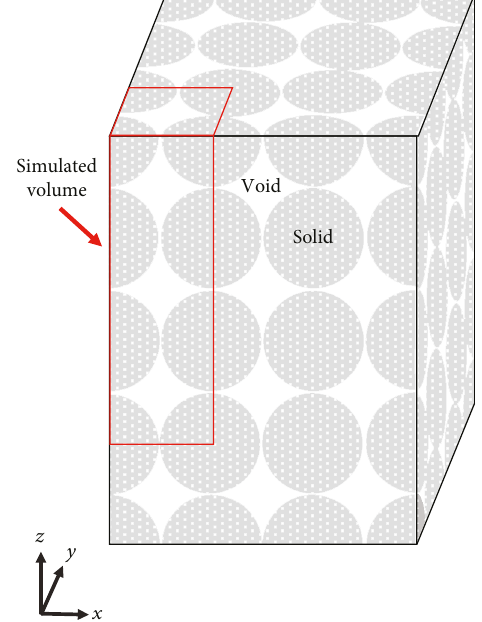
Figure 6: A synthetic porous medium consisting of solid spheres of equal radius (1 mm) and